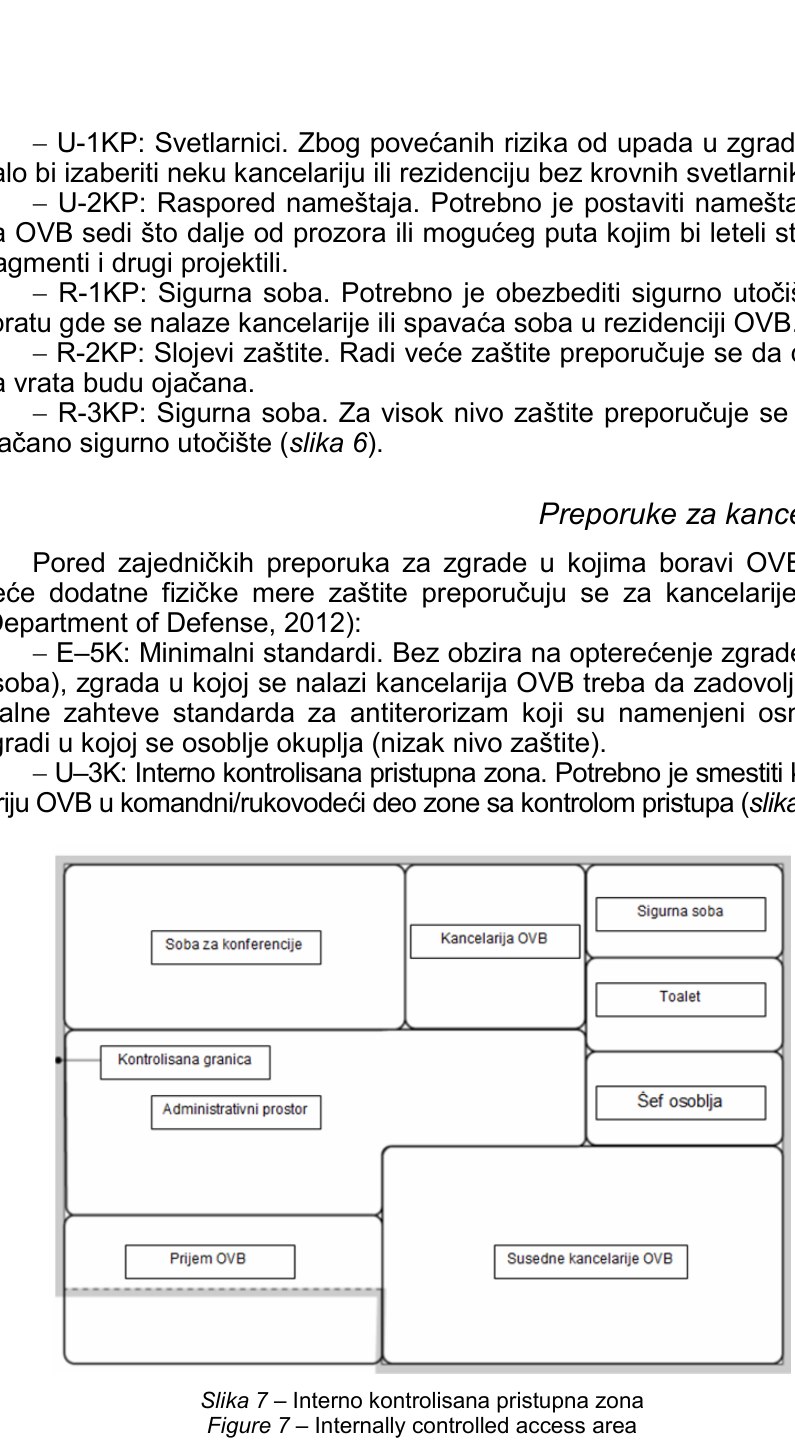
Figure 7 – Internally controlled access